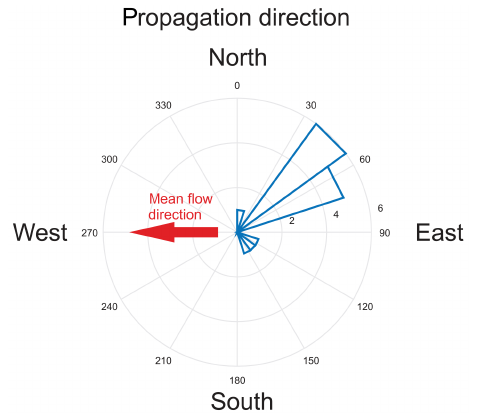
Figure 11. Polar diagram of GWs and ripple propagation direction. The red arrow denotes the mean wind